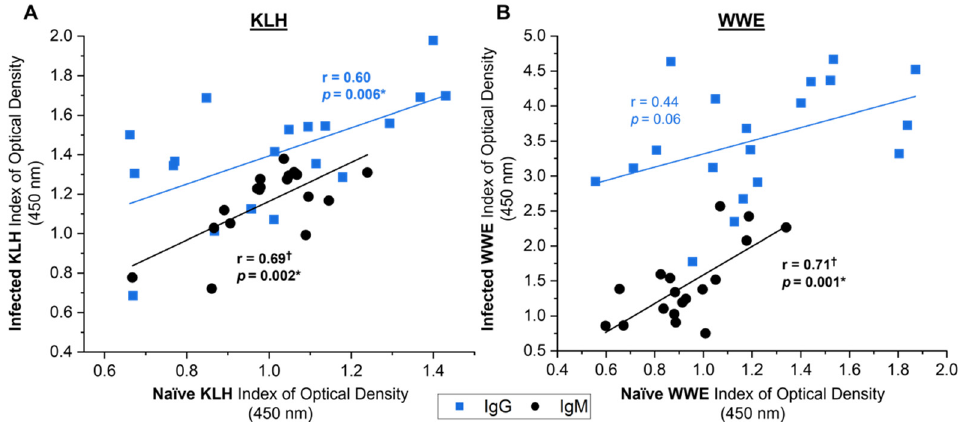
Figure 8. Relationship between antibody responses from the day of infection (naïve) and 6 weeks post-infection (infected) towards the same antigen (KLH) or extract (WWE) in the experimentally infected cows from studies A, B and C ( n = 19). Antibody responses to KLH ( A ) and whole-worm extract (WWE) ( B ) for IgG (blue squares) and IgM (black circles) are shown. Linear regression lines display the antibody response relationship for KLH or WWE between the naïve and infected time points. Pearson’s correlation coefficients (r) and the corresponding significance value are noted on the graph next to the regression line. Results are reported as the mean index ( n = 4) of optical density (450 nm). Significant values ( p < 0.05) are bolded and noted with an asterisk (*). † : datasets that had an outlier removed ( n = 18).